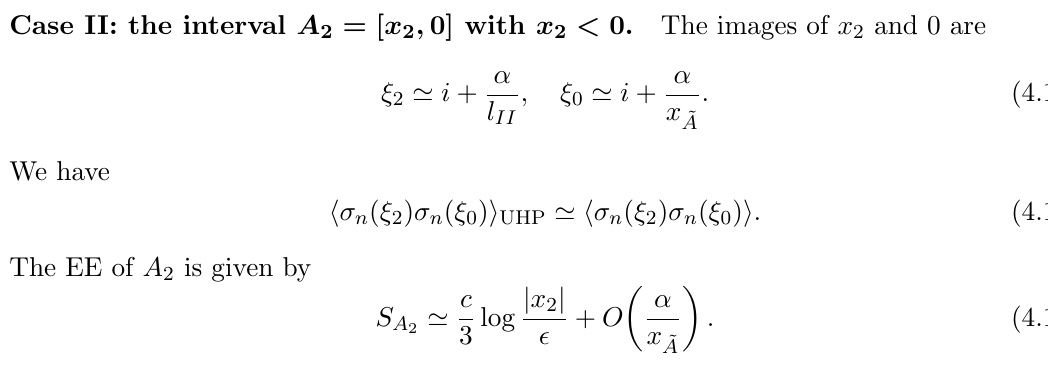
Figure 3 . Path-integral representation of the state j i S